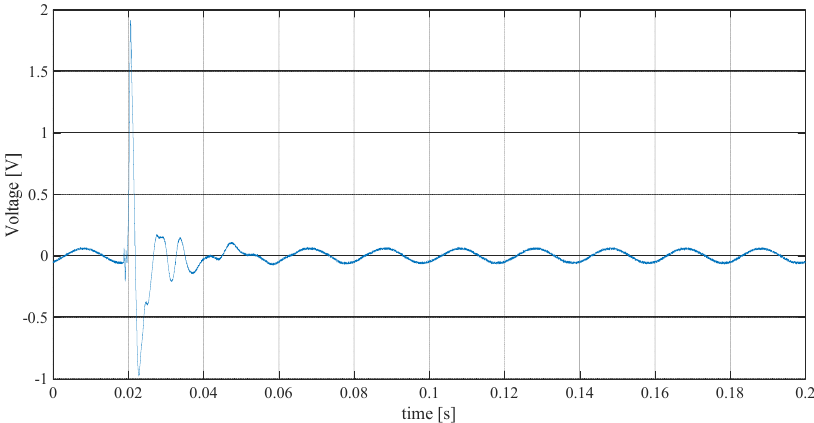
Figure 10. Voltage obtained for the floating structure due to a raindrop falling from 0.5 m, hitting the central point of the floating circle.